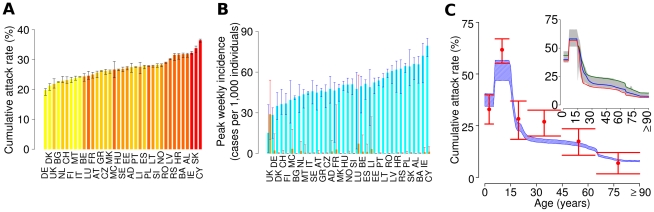
Variation in attack rates by age and country (R0
UK = 1.48 Tg = 3.1 days).(A) Average cumulative attack rate predicted by the model in the different European countries (black bars represent 2.5% and 97.5% percentiles of the distribution). Colours represent the fraction of individuals <15 year old in the population, increasing from yellow (13%) to red (22%). (B) Average peak weekly incidences predicted by the model in the different countries for the summer (orange) and the autumn (cyan) waves; for each country and wave, 2.5% and 97.5% percentiles of the distribution are shown (red and blue bars). (C) Post pandemic age-stratified attack rates. Estimates of post pandemic seroconvertion rates in England [34] (precisely, differences between the percentage of post pandemic (2010) serum samples from England with HI 1∶32 or more, and corresponding percentages in serum samples obtained in 2008 in England) against cumulative attack rates by age in UK predicted by the model at the end of the pandemic: red points represent the expected value of post pandemic seroconversion rates (vertical lines represent 95% confidence intervals), shaded blue areas represent 95% confidence intervals of model simulations. Cumulative attack rates by age as predicted by the model at the end of epidemic in different European countries are shown in the inset: shaded grey area represent 95% confidence interval at European level, while solid lines represent the median for Italy (blue), Germany (red) and Ireland (green). A total of 100 simulations were undertaken to produce the results shown.